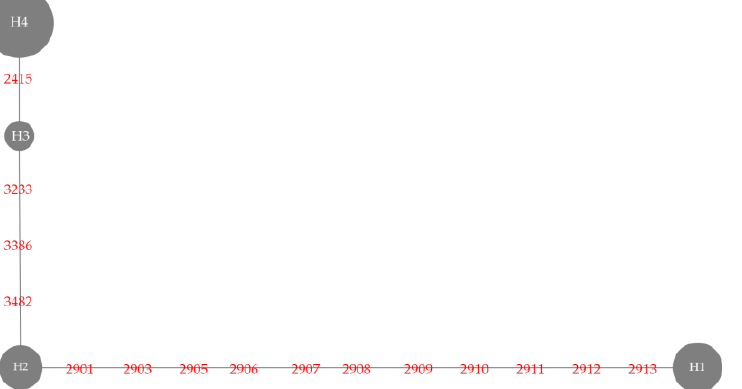
Figure 4. Statistical T-test analysis between the mean sensory test score of the varieties in each haplotype pool versus the score of high check line (a) and low check line (b); *, significant at the 5% level. Aroma was scored as 0 for non-aromatic, 1 for slightly aromatic, 2 for moderately aromatic, and 3 for strongly aromatic. 4. Discussion The 22 rice landraces from northern, northeastern, and southern Thailand and two advanced breeding lines recognized locally as fragrant varieties have been found to vary considerably in their grain morphology, cooking quality, aroma and allelic variation of the fragrant gene Badh2 . The landraces were classified mainly as large grain type, especially those from the highland of the north and northeast, where large grain type rice is preferred, as in the neighboring Lao PDR [58–60]. Diversity of local taste was also indicated in gelatinization temperature variation, ranging from low, in the same range as KDML105 and PTT1; intermediate, similar to the advanced breeding line BNM- CMU; to high as in the elite high yielding, non-aromatic variety SPR1. The premier Thai rice variety KDML105, with its long slender grain, low amylose content and low gelatinization temperature, has become the international standard for aromatic jasmine rice, just as it has long been in Thailand [61]. The grain quality features of KDML105 provide the benchmark for the selection of jasmine type grain quality in Thai breeding programs [31,36], and other areas [62–64], which commonly utilize KDML105 or other genotypes with similar grain quality characteristics as the parent. The rice landraces in this study clearly differentiate from KDML105 in their grain quality. The majority of the accessions belong to the large grain type. The few slender grain accessions either had high gelatinization temperatures or were non-aromatic when grown in Chiang Mai. Similar to the local Indian aromatic rice varieties of small and medium grain that are classed as non-Basmati [2], the local